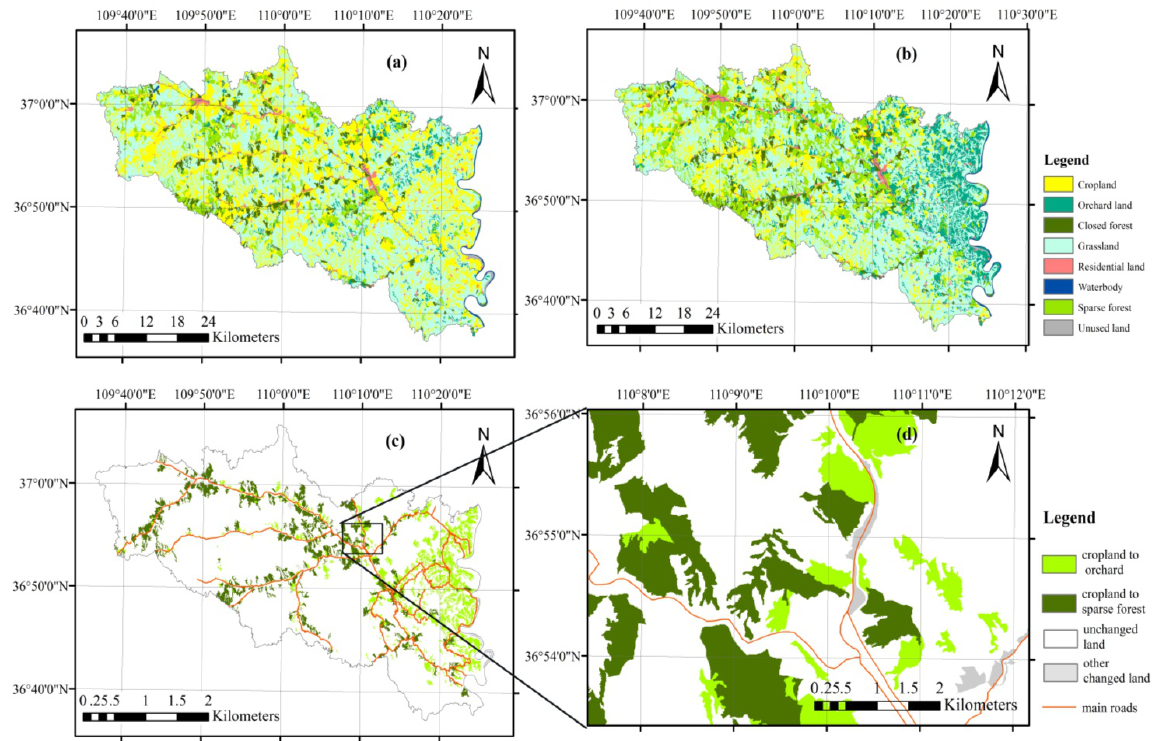
Figure 2. Geographical distributions of land use/cover in Yanchuan County. ( a ) Land use/cover in 1999; ( b ) Land use/cover in 2011; ( c ) main land use/cover changes; ( d ) A part of main land use/cover